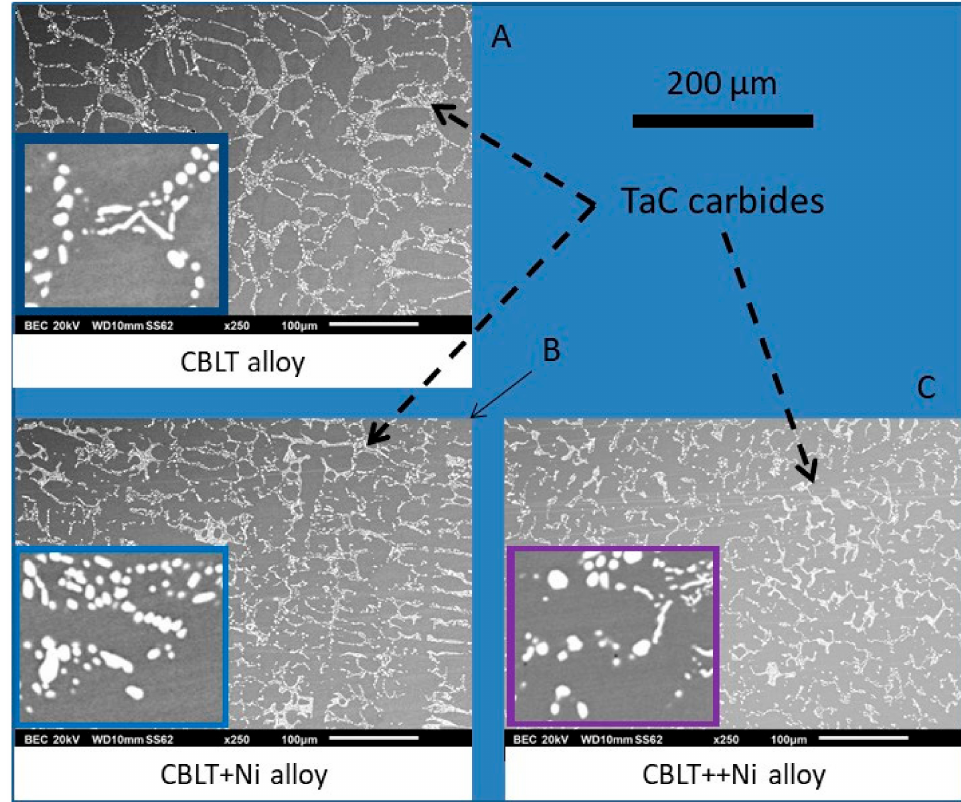
Figure 10. View of the carbides population in the bulk after 70 h at 1250 ◦ C (large micrographs 250; inserted micrographs × 2000): ( A ): the CBLT alloy; ( B ): the CBLT+Ni alloy; ( C ): the CBLT++Ni